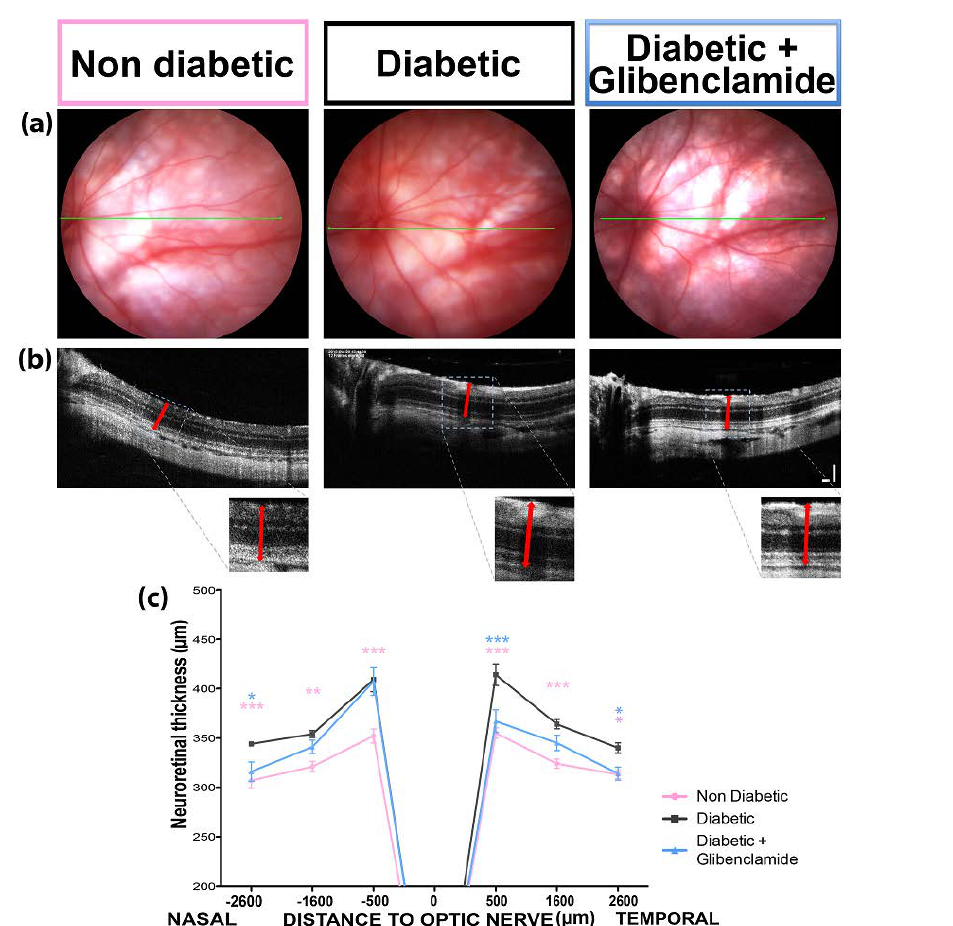
Figure 3. Long-term low-dose oral glibenclamide treatment reduces diabetes-induced retinal edema in diabetic Goto-Kakizaki rats. ( a ) Fundi pictures of 1-y-old non-diabetic female, diabetic and glibenclamide-treated diabetic rats obtained with Micron III device (Phoenix Research Labs); ( b ) cor- responding Micron III OCT pictures used to measure neuroretina thickness at fixed distances from the optic nerve and known orientation (nasal-temporal); insert = thickness measurement; vertical scale bar = 200 µ m, horizontal scale bar = 100 µ m. ( c ) Neuroretinal thicknesses at 500, 1600 and 2600 µ m from the optic nerve, in nasal and temporal directions, in non-diabetic Wistar and female GK (pink line), diabetic (black line) and glibenclamide-treated diabetic (blue line) rats ( n = 6 to 20 eyes). Two-way ANOVA and Bonferroni’s post-test vs. diabetic group; * p < 0.05, ** p < 0.01, *** p <